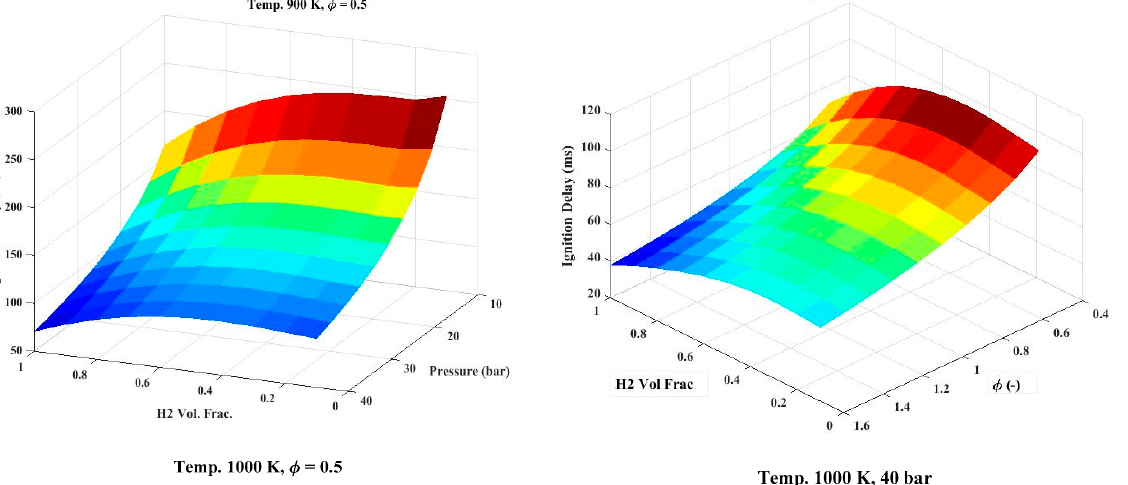
Figure 12. Effect of H 2 addition on methane’s ignition delay times at different temperatures at p = 40 bar (right image shows the normalized ignition delay time error for each case). Figure 13 depicts the influence of hydrogen addition on laminar flame speeds of me- thane at different pressures and equivalence ratios. As expected, by decreasing pressure and increasing hydrogen volume fraction, laminar flame speed enhances. This increment is significant at higher equivalence ratios and hydrogen volume fractions. It is interesting to note that effect of hydrogen fraction is much prominent at higher equivalence ratios, indeed laminar flame speed was not affected by hydrogen addition at (cid:2038) = 0.5. Therefore, combination of H 2 volume fraction and equivalence ratio has considerable effect on me- thane’s laminar flame speed. Temperature (K) I g n i t i o n D e l a y